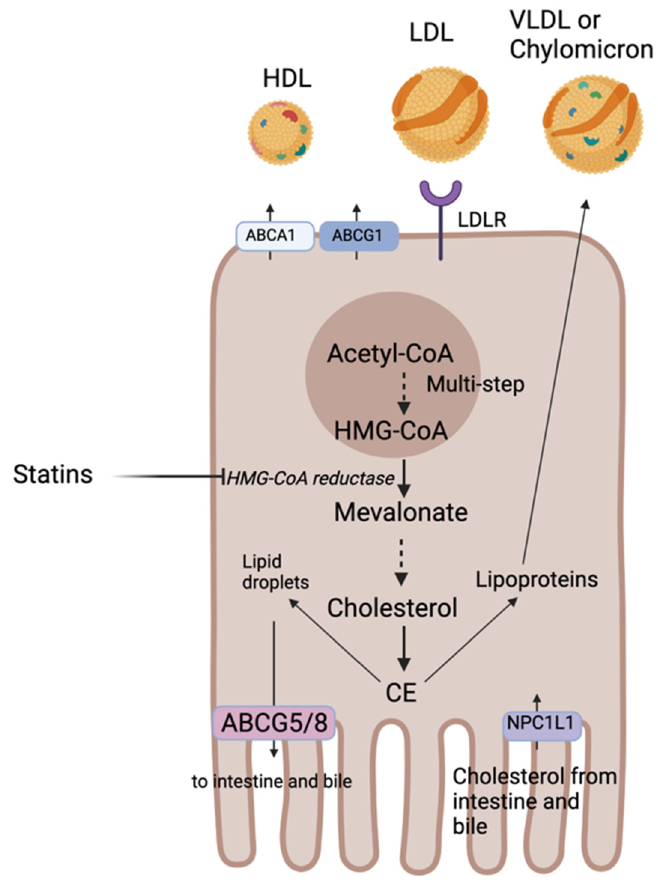
Figure 1. Metabolism, import, and export of cholesterol in polarized cell. The bulk of endogenous cholesterol is synthesized by the liver and starts from acetyl coenzyme A (acetyl-CoA) and concerted actions of more than 20 enzymes. Once cholesterol is formed, it is either esterified to cholesterol ester (CE) and stored in lipid droplets or secreted into the bloodstream as lipoproteins. Excess cholesterol can be excreted by ABC subfamily G member 5 and member 8 (ABCG5/8) transporters to the intestine or to the bile or packaged with lipoproteins for subsequent secretion into the blood.